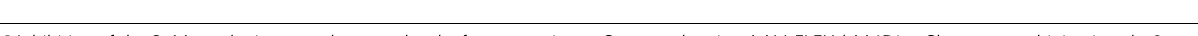
Fig. 4 Inhibition of the SuM results in somnolence and wake fragmentation. a Cartoon showing AAV-FLEX-hM4Di-mCherry recombining in vglut2 neurons that express Cre. b Conditional transduction of inhibitory hM4Di in vglut2-IRES-Cre mice (red − brown staining outlined in red; scale bar 500 µ m). c − g CNO (5 µ M) inhibits the fi ring of SuM vglut2 neurons that express hM4Di-mCherry ( c current-clamp recordings; d cell attached recordings; e − g expanded traces of the outlined region from d , show fi ring in control, during CNO application and in washout). h − j CNO (5 µ M) has no effect on the fi ring of SuM vglut2 neurons that only express mCherry ( h ; fi ring frequency, 1-min bin, red arrows indicate the 1-min bins represented in i , j ; i , j cell attached recordings of the neuron in h ). k , l Hypnograms from two mice over 12 h after vehicle and CNO, showing increased sleep and fragmentation of sleep and wakefulness after inhibition of the SuM. m , n CSA after vehicle and CNO from the periods shown by the blue and red boxes, respectively, in c and d (0 − 100 Hz, black bar shows the dark period, short white bars represent 20 min and are spaced 1 h apart). o There is increased overall NREM sleep in the 6 h after CNO administration (~20%; 2-way ANOVA for 6-hourly bins between vehicle and CNO, graph with mean ± SEM, p = 0.0199), p wake-sleep fragmentation with an increase in sleep bouts over the 6 h after CNO when compared with vehicle (paired t -test, mean ± SEM, p = 0.0194). q The length of the longest episode of wakefulness in the same time period was also signi fi cantly reduced (paired t -test, mean ± SEM, p = 0.0152). r Power spectrum (band mean ± SEM) with a signi fi cant suppression of waking high theta activity (2-way repeated measures ANOVA, Bonferroni *** p < 0.0001) and gamma activity (* p = 0.0472), and s an unexpected increase in low theta power during REM sleep (*** p < 0.0001), with t no change in the NREM